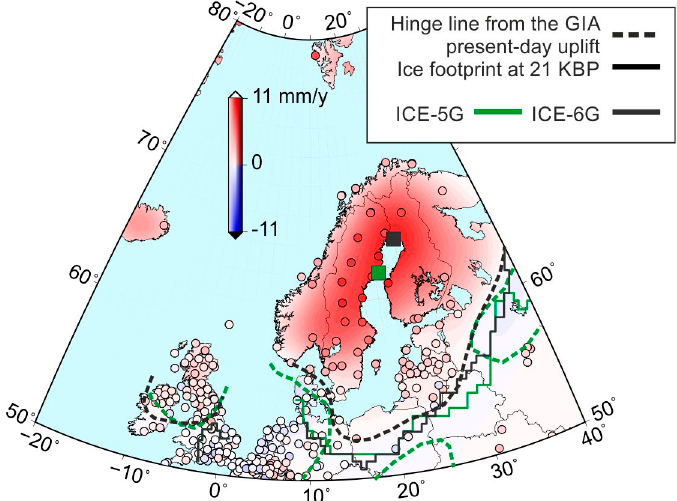
Figure 8. The vertical rates derived from the NGL position time series, plotted in mm / yr as colored dots. The present-day vertical rates predicted by the ICE-6G GIA model are given as the background colored map. The present-day center of uplift of the ICE-6G GIA model is plotted as a black square with a vertical rate of 9.7 mm / yr. The present-day center of uplift predicted by the previous GIA model, i.e., ICE-5G, is plotted as a green square with a vertical rate of 9.3 mm /